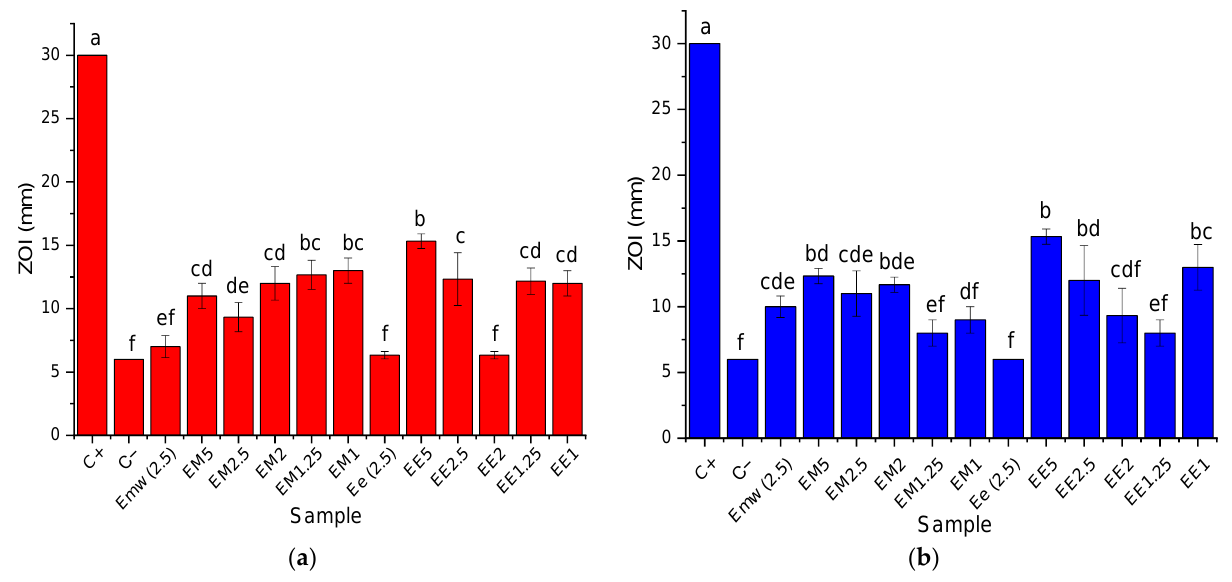
Figure 8. Antimicrobial activity of the tested samples against ( a ) Candida albicans ATCC 64548; ( b ) Escherichia coli ATCC 8738. C+ — positive control (as described in the Methods section); C −— negative control (water); E mw (2.5) — microwave-assisted extract at 2.5 mg/mL; E e (2.5) — classical temperature extract at 2.5 mg/mL. Values represent the mean ± SE, n = 3 per treatment group; values without a common lowercase letter differ statistically ( p < 0.05) as analyzed via one-way ANOVA and the TUKEY